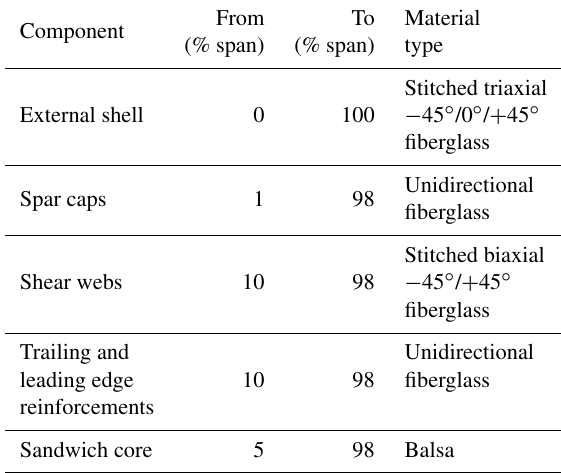
Table 1. Configuration of the 2.2MW onshore wind turbine. Data Value Data